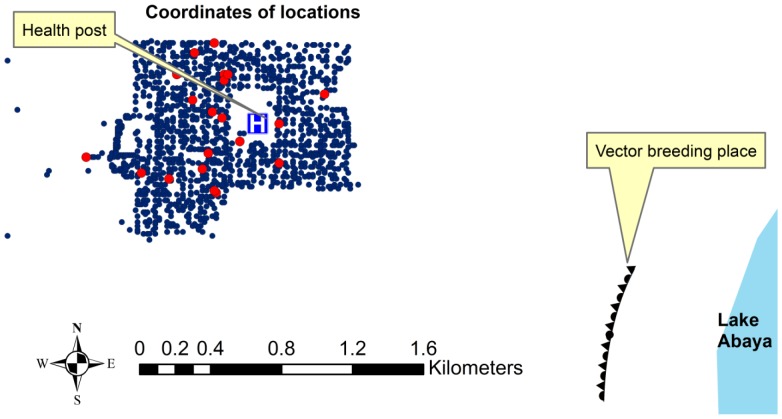
Spatial coverage of insecticide treated bednets (ITNs): Red dots refer to households that did not receive ITNs and smaller blue dots refer to those who received at least one ITN.